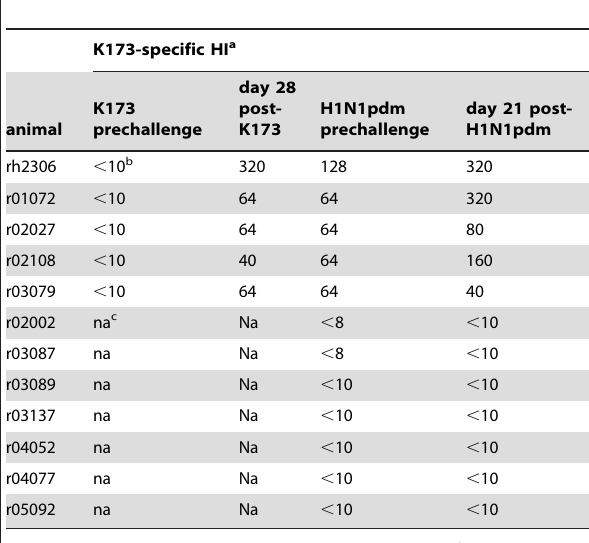
Table 1. Serum antibody titers against seasonal virus K173.